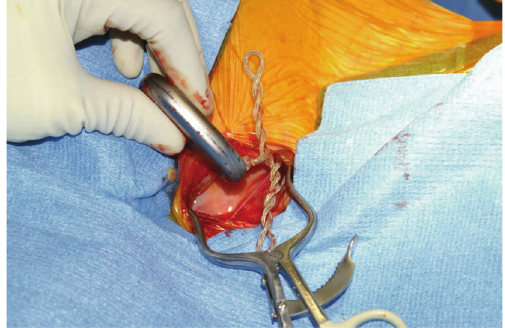
Figure 4: Appearance of the right IPG and extension lead during the fourth operation. Note the extensively coiled extension lead.